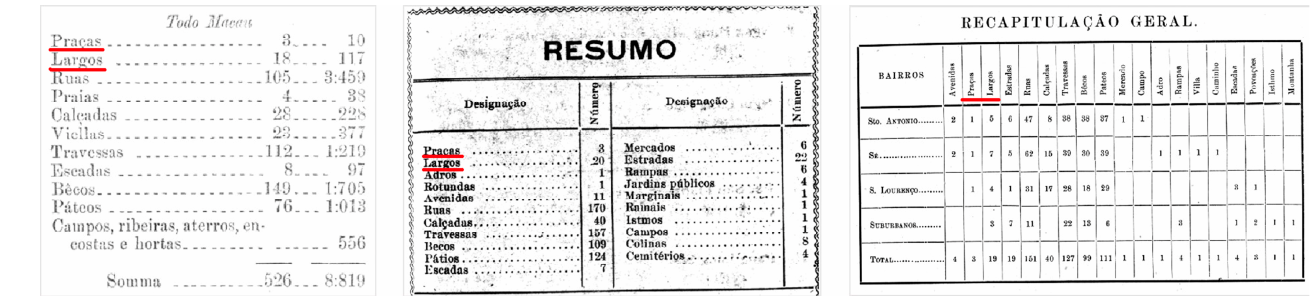
Figure 2. Lists of roads in Macau in 1867, 1906 and 1925.